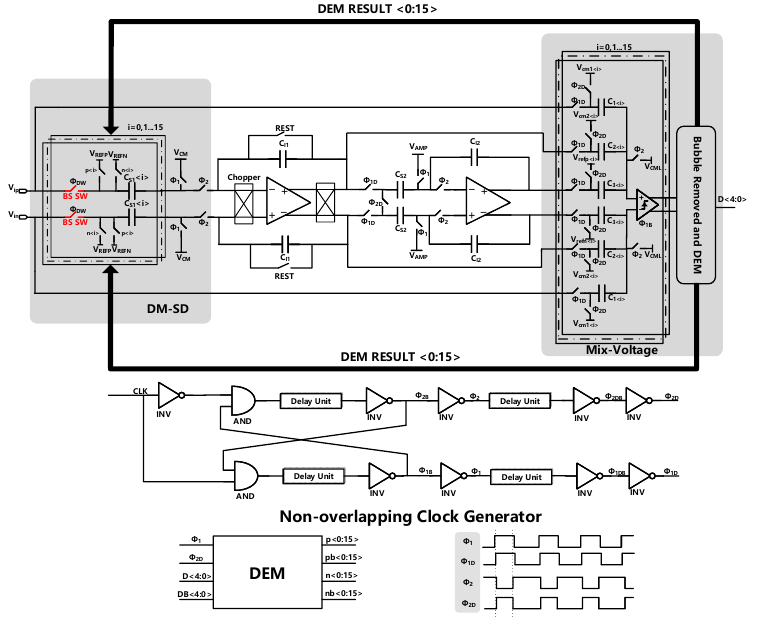
Figure 4. Top-level schematic of the proposed DT Σ∆ modulator and the non-overlapping